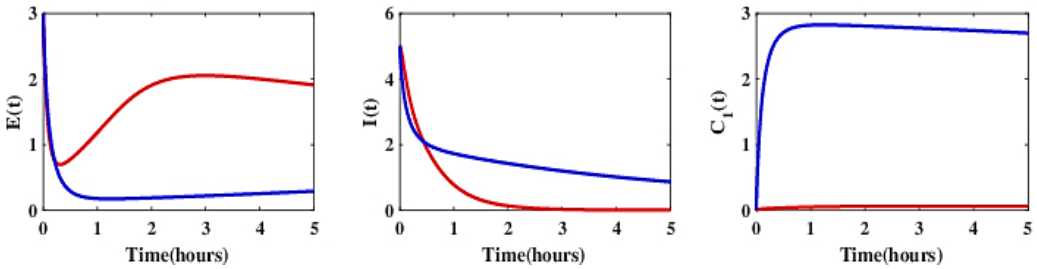
Figure 5. Comparison study between absence of alcohol and presence of alcohol for enzyme, protease inhibitor and complex 𝐶 with the initial conditions 𝐸 1 5.0 𝜇𝑚𝑜𝑙/𝐿 and 𝐶 = 0 [Blue line indicates absence of alcohol while red line indicates presence of 10